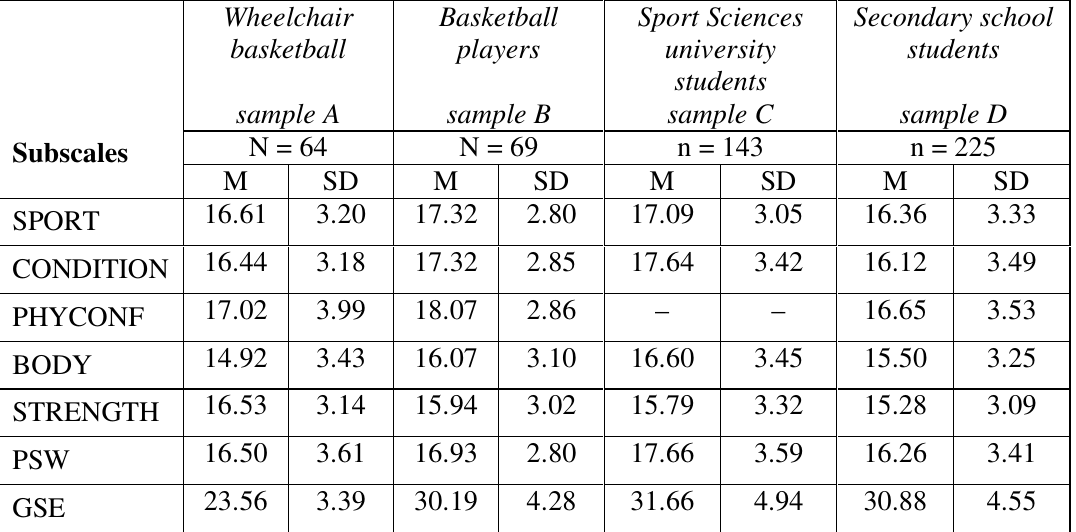
Means and standard deviations from PSPP subscales – basketball players with and without